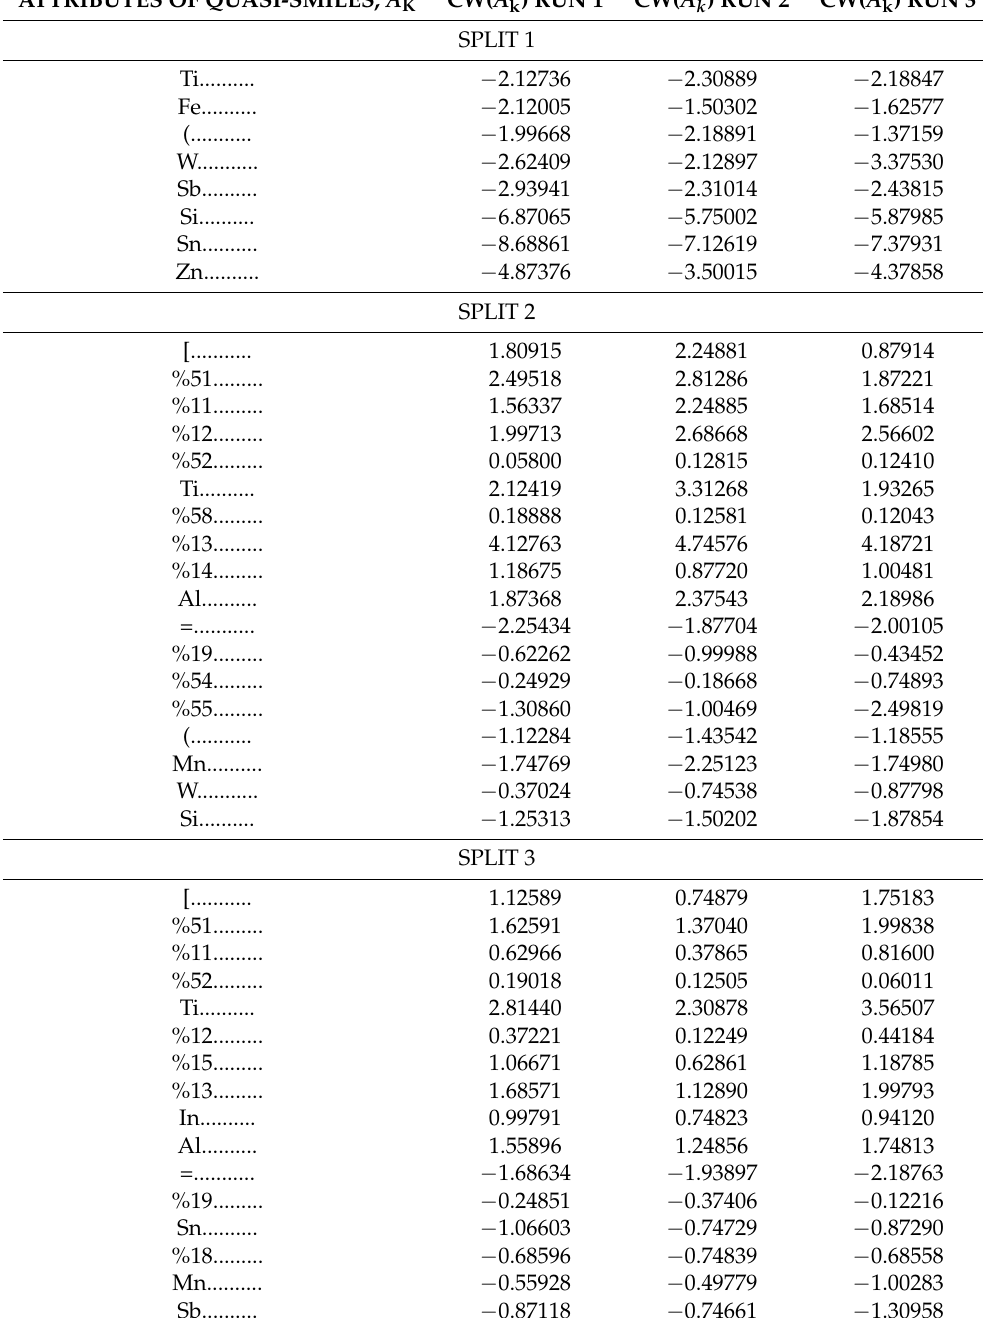
ATTRIBUTES OF QUASI-SMILES, A